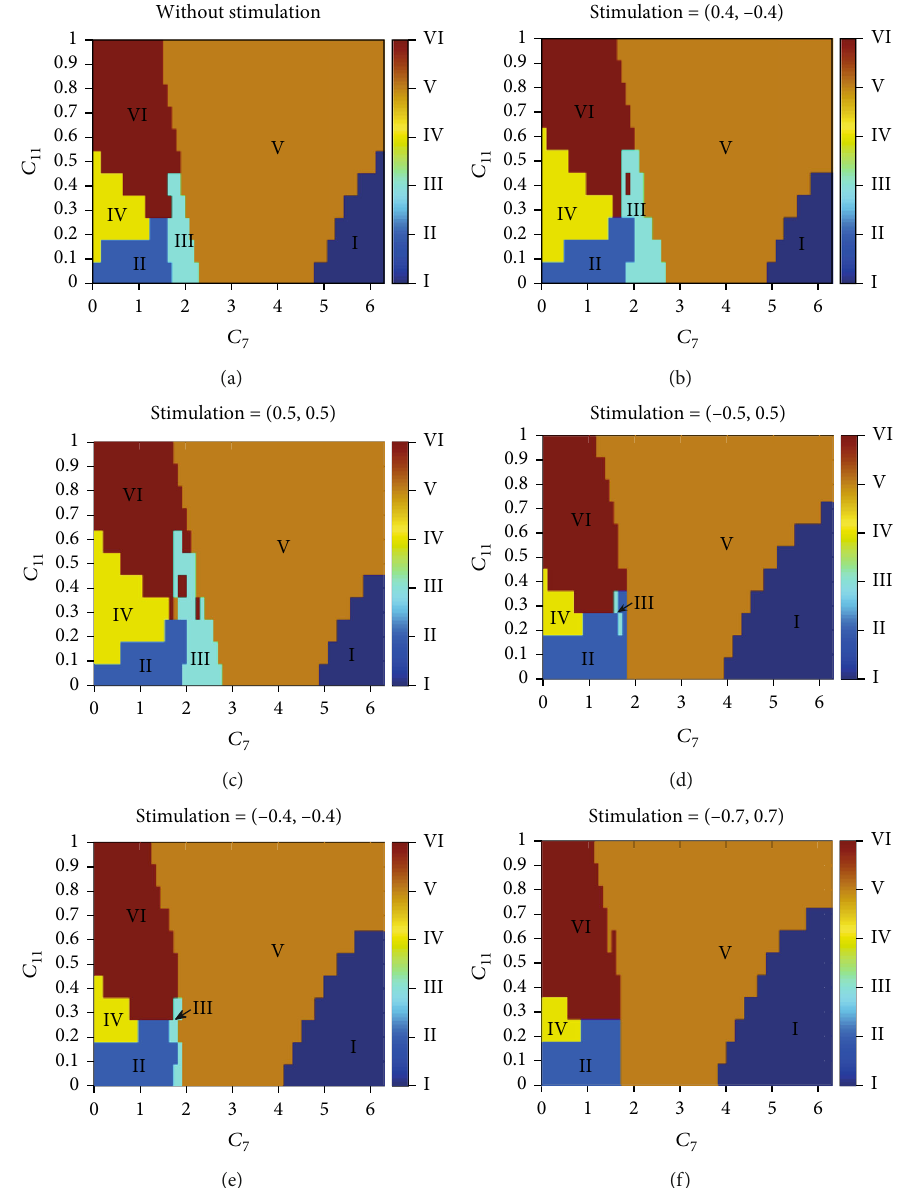
Figure 12: State types after applying CRS with di ff erent stimulus intensities on RE and TC, where I (high saturated state), II (low saturated state), III (SWD), IV (tonic), V (low-frequency clonic), and VI (high-frequency clonic) are six di ff erent fi ring states. (a – f) Is the two- dimensional parametric plane ( C 7 , C 11 ) without CRS. These typical two-dimensional plane diagrams show that SWD can be controlled well by CRS. And (-0.7, 0.7) is the most e ff ective strategy for absence